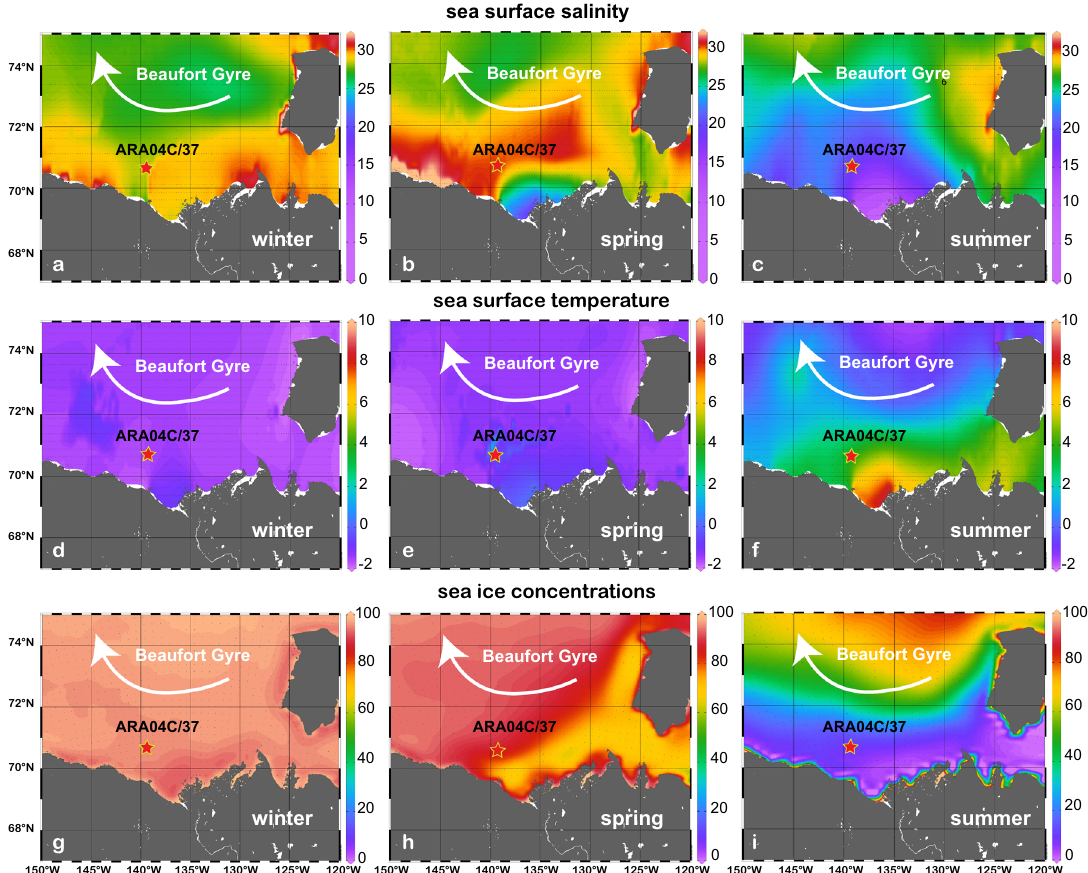
Fig. 2 Modern surface water characteristics in the Beaufort Sea. a – c modern sea surface salinity, d – f modern sea surface temperature, g – i modern sea- ice concentrations. Data of ( a – f ) are from the World Ocean Atlas 2013 (data source: https://www.nodc.noaa.gov/OC5/woa13/). Data of ( g – i ) are averaged sea-ice concentrations from 1988 to 2007 (data source: http://nsidc.org). Maps were produced with Ocean Data View software (source: http:// odv.awi.de/). White arrow represents the Beaufort Gyre circulation. Red star indicates location of Core ARA04C/37.